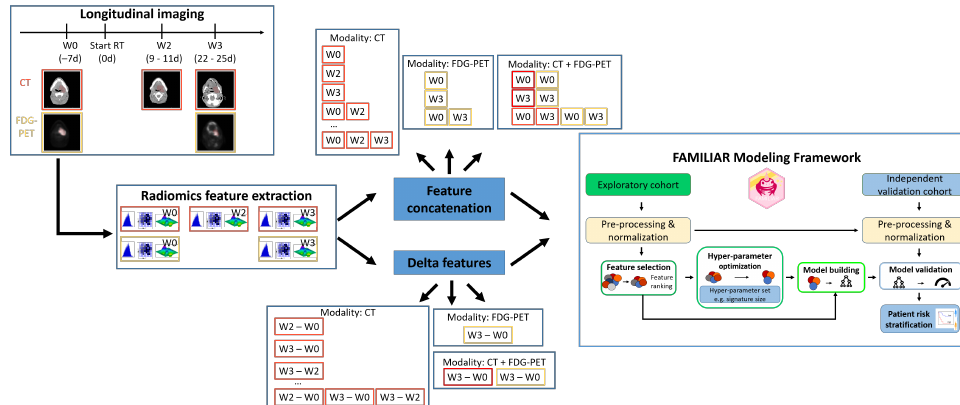
Figure 1. Design of our longitudinal and multimodal analysis. Radiomics features were extracted from a longitudinal collection of CT and FDG-PET scans. Features of different timepoints and modal- ities were combined and used as input to a machine learning pipeline that fitted Cox proportional hazards models for the prediction of loco-regional control. The 37 patients in the exploratory cohort were used for model building. The fitted models were then evaluated using the data from the 18 patients in the second cohort for independent